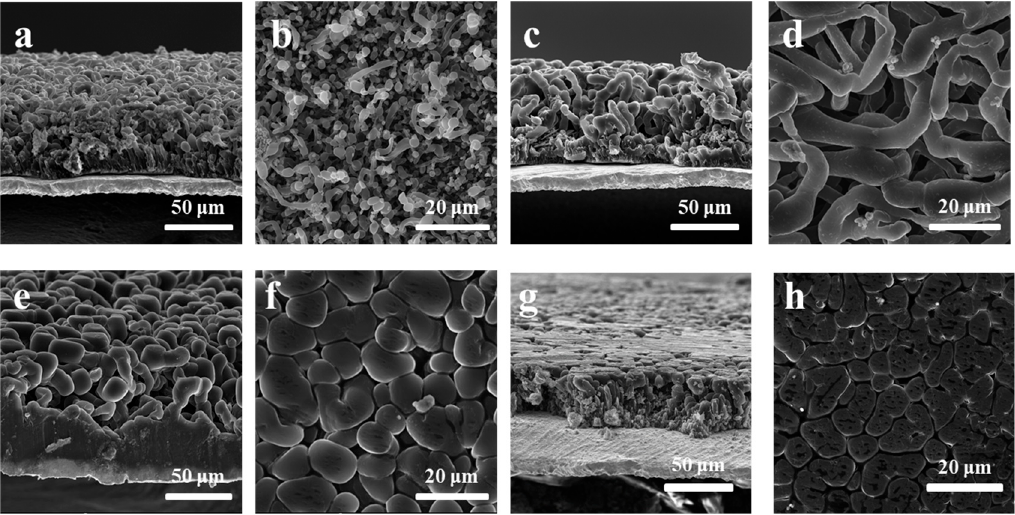
Figure 3. SEM images of the nanospheres or lithium deposition. ( a ) Cross-section of lithium deposited on SAZ nanospheres. ( b ) Top view of lithium deposited on SAZ nanospheres. ( c ) Cross-section of lithium deposited on FAS nanospheres. ( d ) Top view of lithium deposited on FAS nanospheres. ( e ) Cross-section of lithium deposited on FSZ nanospheres. ( f ) Top view of lithium deposited on FSZ nanospheres. ( g ) Cross-section of lithium deposited on FAZ nanospheres. ( h ) Top view of lithium deposited on FAZ nanospheres.